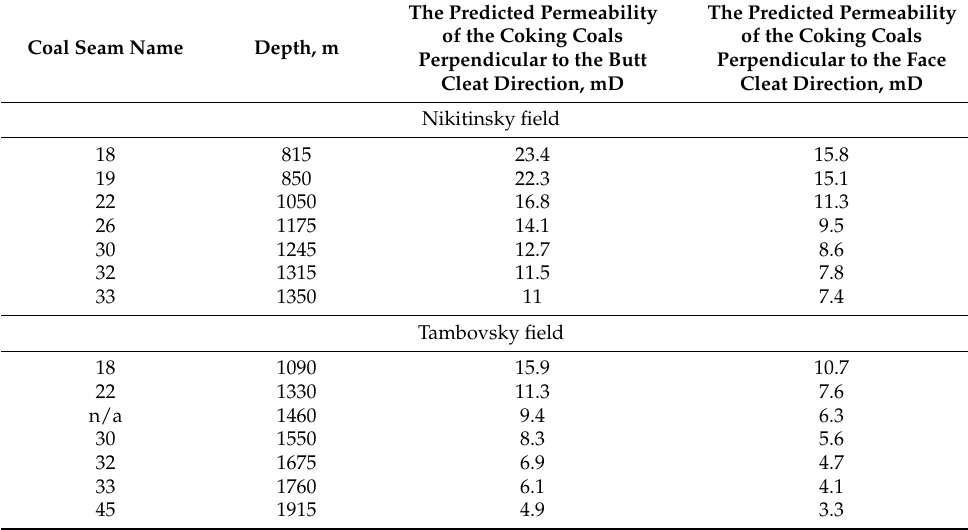
Table 5. The predicted coking coal permeabilities for stress regime, described by uniaxial strain and horizontal stress across